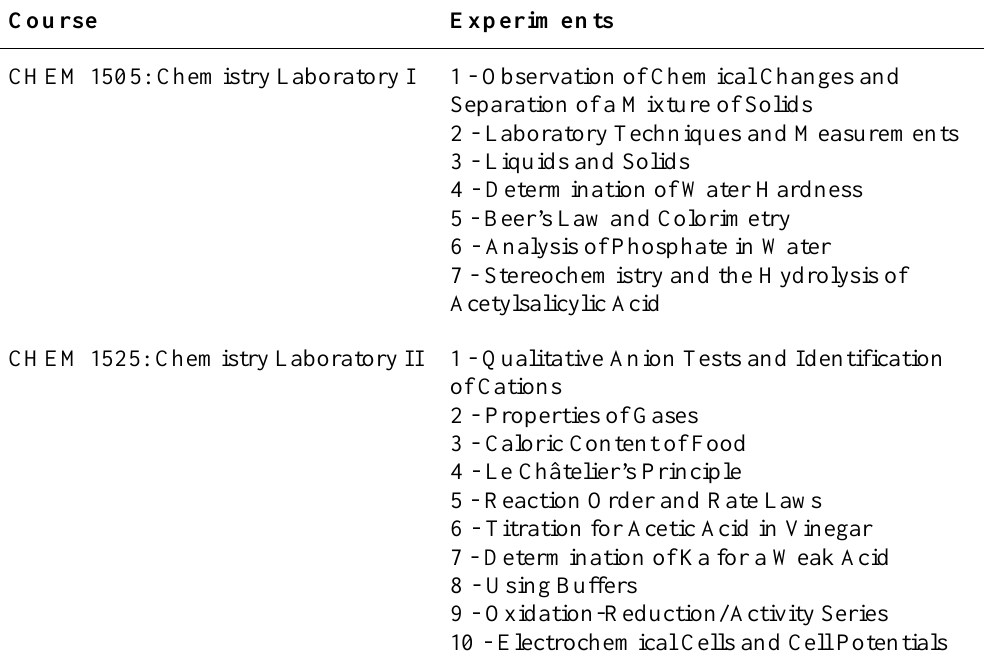
List of Experiments Included in the New Laboratory Courses